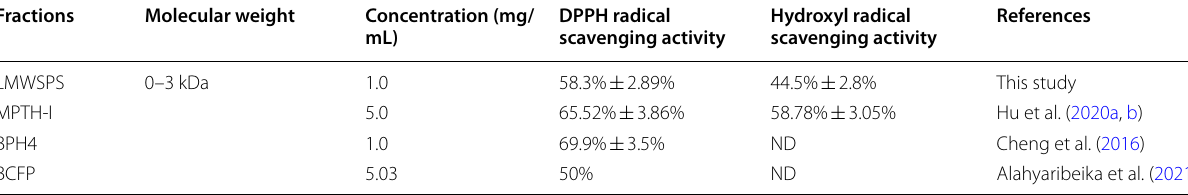
Table 1 Comparison of antioxidant activities between peptides (0–3 kDa) of four different